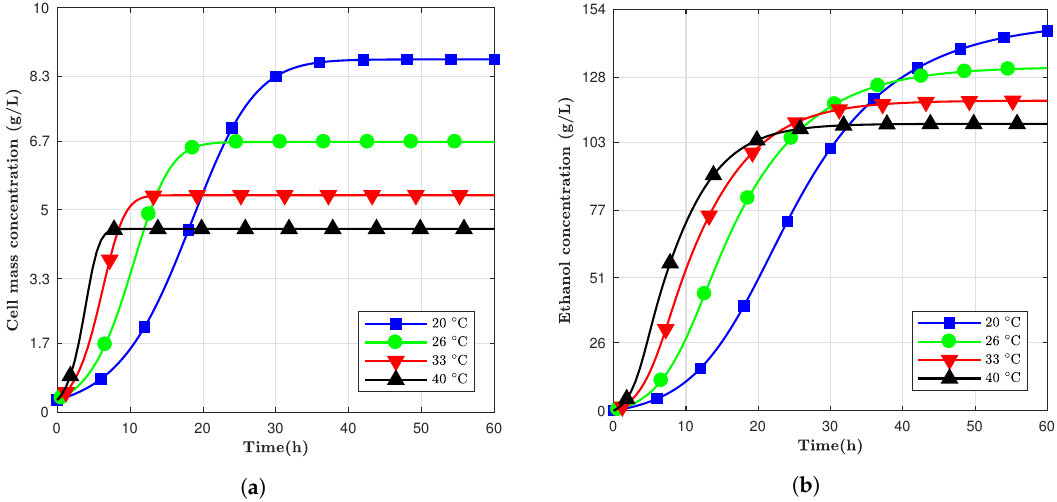
Figure 1. Simulation results using fixed temperature for ( a ) cell mass concentration; ( b ) ethanol